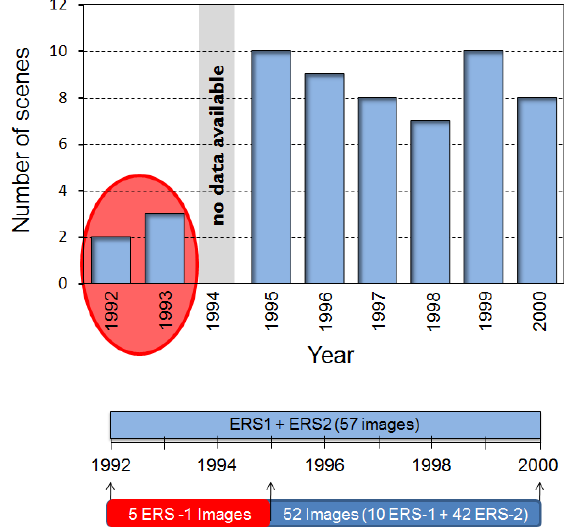
Fig. 3. Distribution over time of the images used in this study. The scenes acquired before 1995 have been discarded from the dataset to ensure continuity and feasibility of the interferometric analysis.